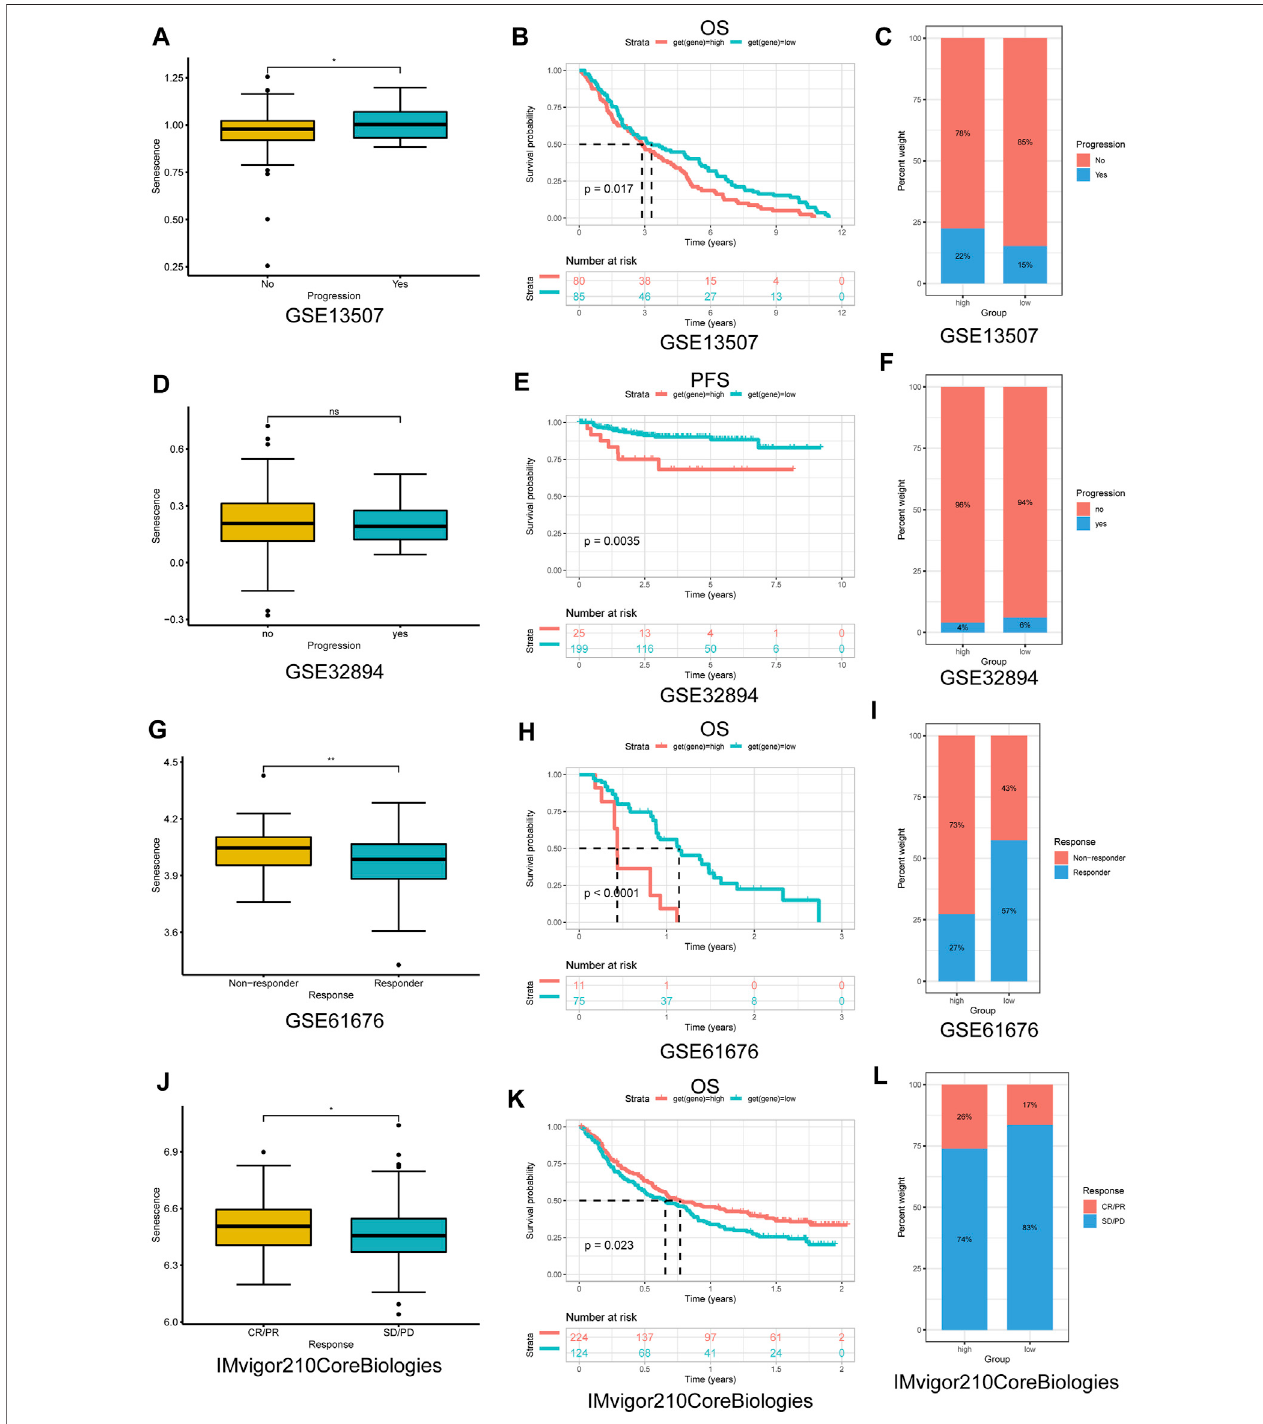
FIGURE 14 | The application of senescence score (SS) in cancer nonimmune/immune-checkpoint therapy. (A,D,G,J) The distribution of the SS among samples wasstrati fi ed byresponseto nonimmune/immune-checkpointtherapy in each dataset. (B,E,H,K) Kaplan – Meier analysisof overall survival/PFS between high- and low- SS groups in each dataset. (C,F,I,L) The proportion of response to nonimmune/immune-checkpoint therapy between high- and low-SS groups in each dataset. (A – I) Nonimmune-checkpoint therapy; (J – L) immune-checkpoint therapy. PFS, progression-free survival; CR, complete response; PR, partial response; SD, stable disease; and PD, progressive disease ( p < 0.05 was considered signi fi cant, * p < 0.05; ** p < 0.01).